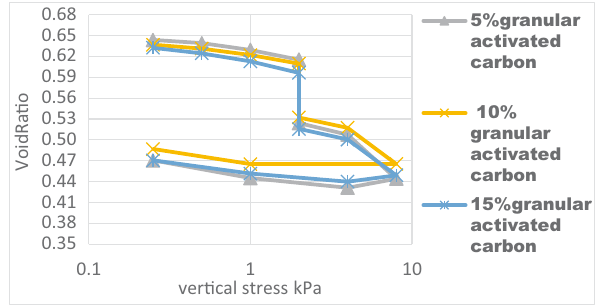
Figure 3: Collapse test results for soil treated with ( 5, 10, 15% ) GAC.